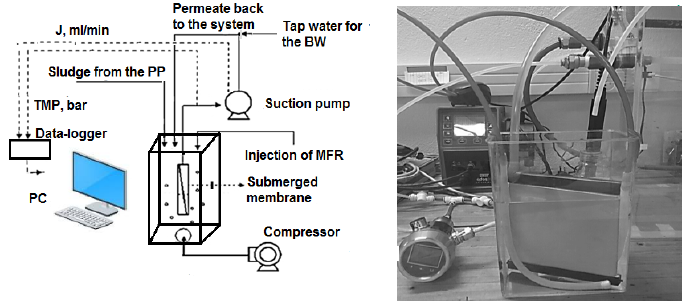
Figure 1. The total recycle test system, adapted from [43].